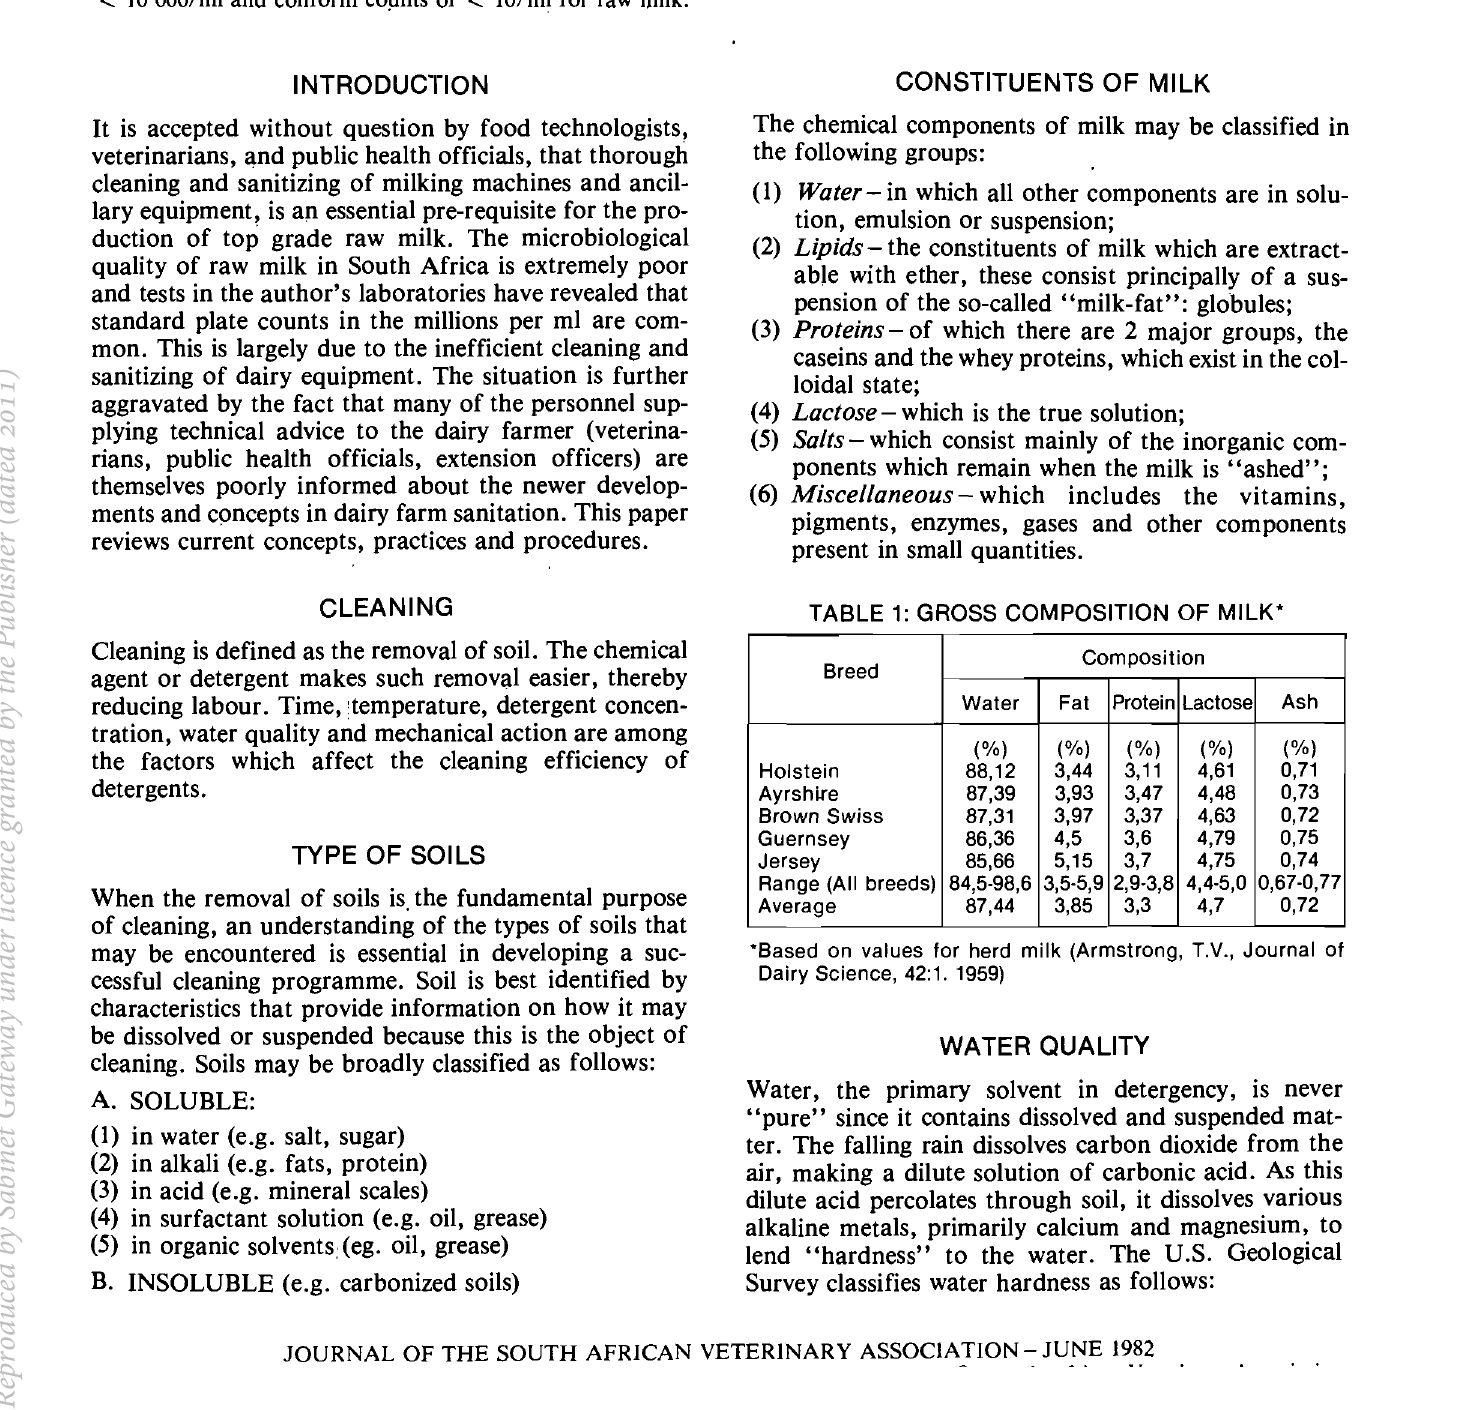
TABLE 1: GROSS COMPOSITION OF MILK" Breed